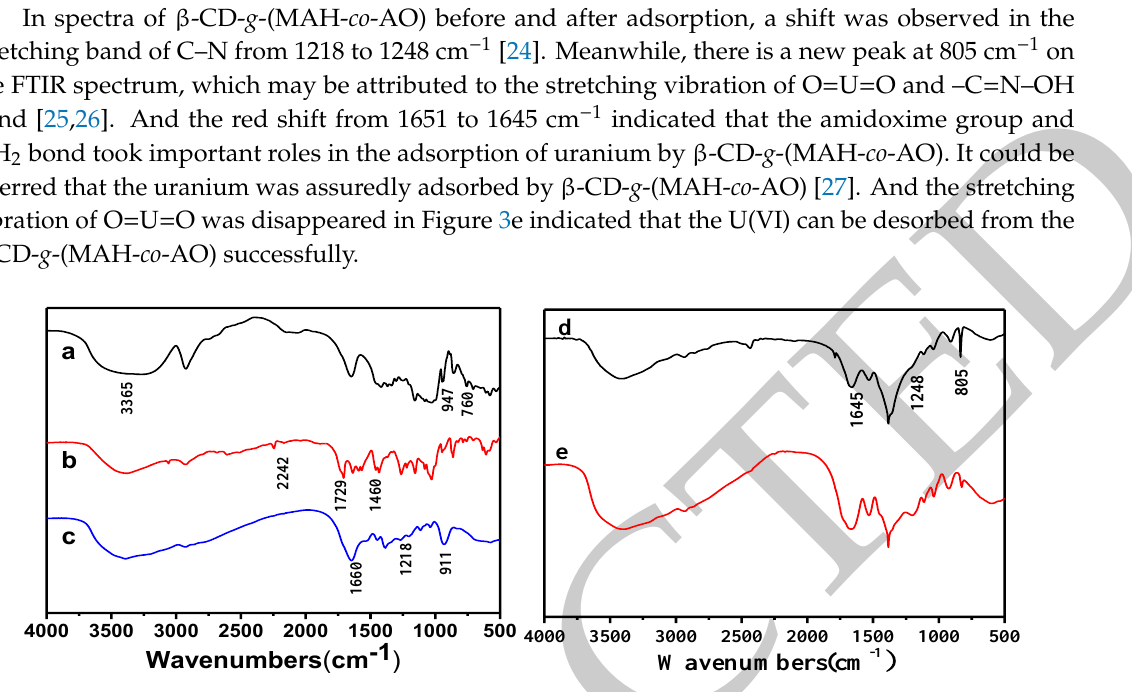
Figure 3. FT-IR spectra of β -CD (a); β -CD- g -(MAH- co -AN) (b); β -CD- g -(MAH- co -AO) (c); β -CD- g -(MAH- co -AO) adsorption of U(VI) (d); β -CD- g -(MAH- co -AO) desorption of U(VI) (e).